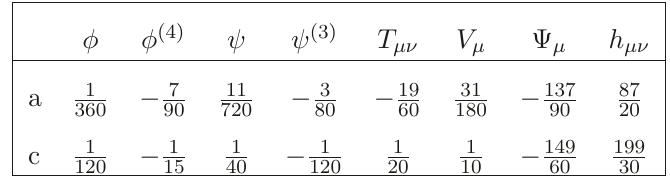
= 1 superconformal N